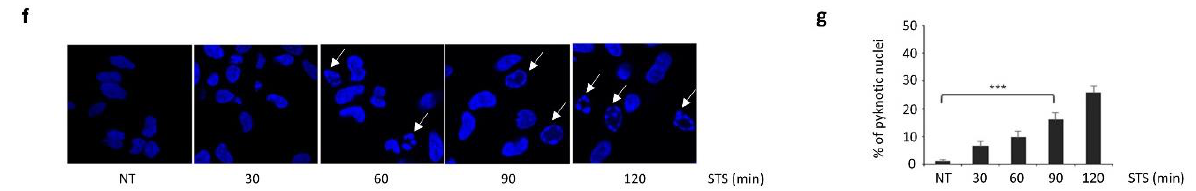
Figure 1. STS treatment induces autophagosome enhancement followed by a progressive activation of apoptosis in SH-SY5Y cells. ( a ) Representative pictures of SH-SY5Y cells stably expressing GFP–LC3 treated with either STS (at the indicated time points) or DMSO (NT); ( b ) the count of cells showing GFP–LC3 autophagic vacuoles (puncta) showed maximum autophagy activation at 90 min; ( c ) in immunoblots, autophagy induction was monitored analyzing the conversion of endogenous LC3 from the cytoplasmic (LC3-I, 18kDa) to the membrane-bound form (LC3-II, 16kDa), while apoptosis was monitored by cleaved PARP; ( d ) densitometric analysis of LC3-II/LC3-I ratio showed a progressive increment until a three-fold increase at 90 min (2.74 ± 0.06, p = 0.0008); ( e ) densitometric analysis of cleaved PARP showed a significant increase since 90 min from STS exposure (3.31 ± 0.003, p = 0.0001). GAPDH protein levels were used for normalization; ( f ) Western blot data were confirmed by confocal analysis of apoptotic cells, identified by irreversible chromatin condensation within pyknotic nuclei (white arrows). ( g ) The count of pyknotic nuclei showed a significant increase over time after STS treatment. Experiments performed in triplicate; a minimum of 200 cells per experiment were analyzed; mean ± S.E.M.). *** p ≤